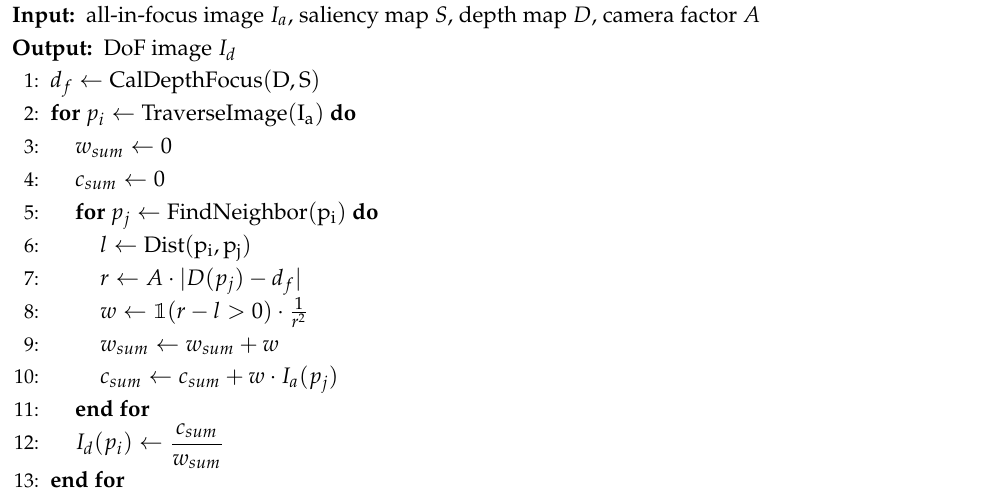
Algorithm 2 The pipeline of rendering method